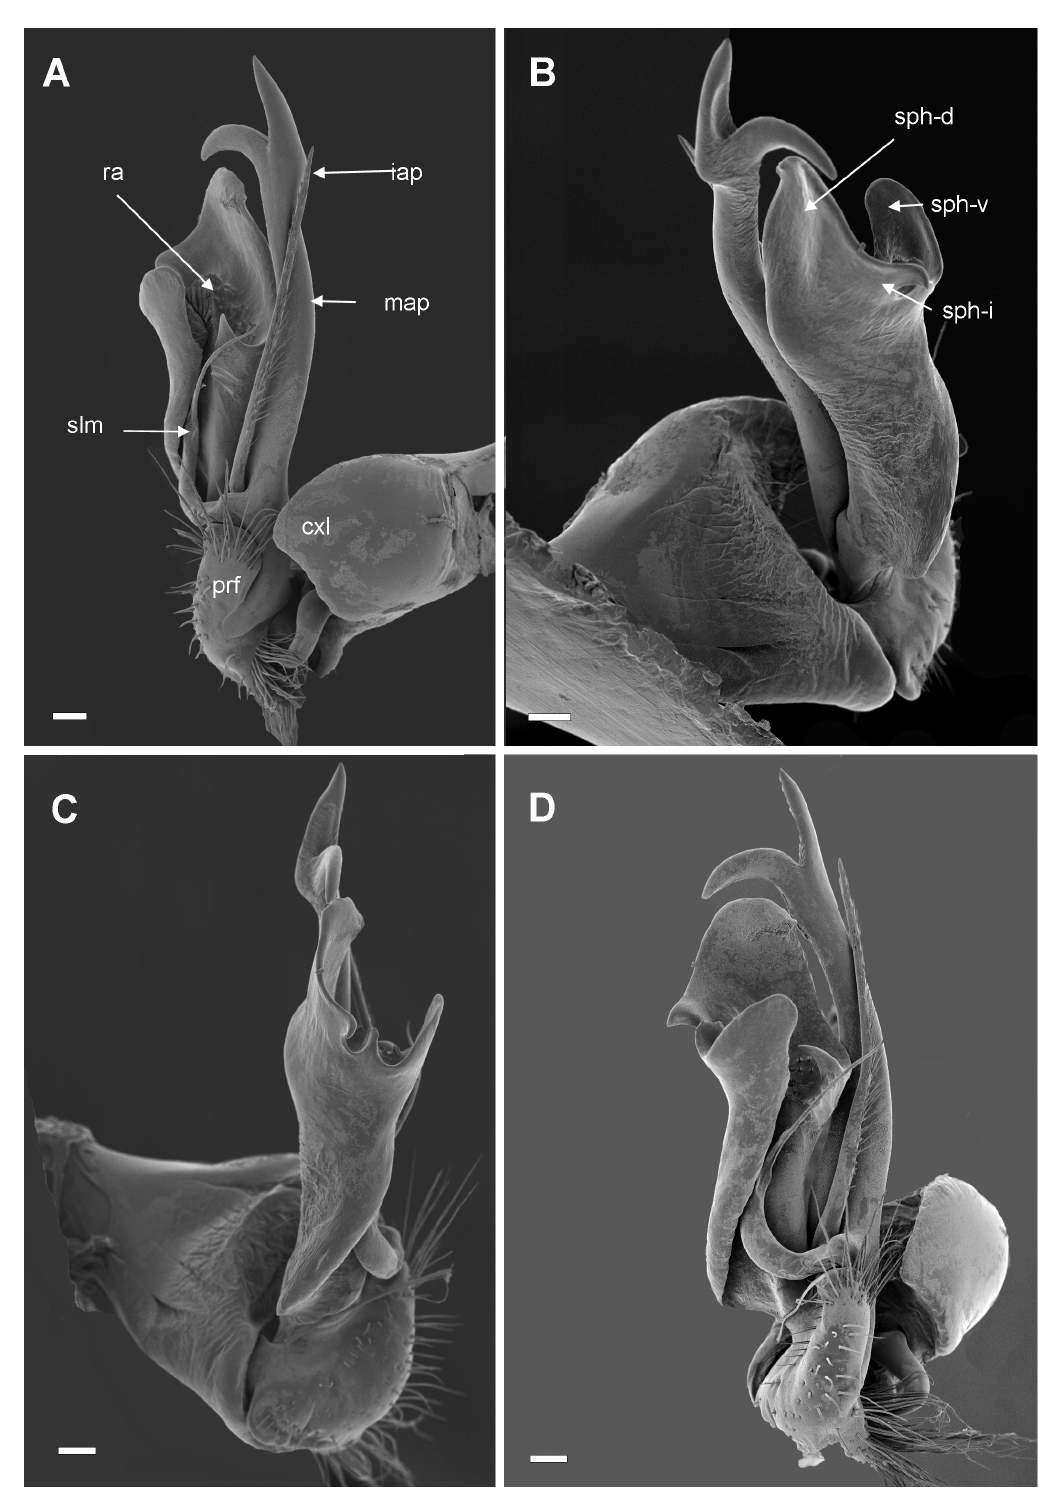
Fig. 18. Eviulisoma navuncus sp. nov., holotype, right gonopod. A . Mesal view. B . Lateral view. C . Ventro-lateral view. D . Ventral view. Aluminium tape used for mounting visible in lower left corner of B. Abbreviations: cxl = coxal lobe; iap = intermediate acropodital process; map = mesal acropodital process; prf = prefemoral part; ra = ridged area of solenophore; slm = solenomere; sph-d , sph-i , sph-v = dorsal, intermediate and ventral lobes of solenophore. Scale bars: 0.1